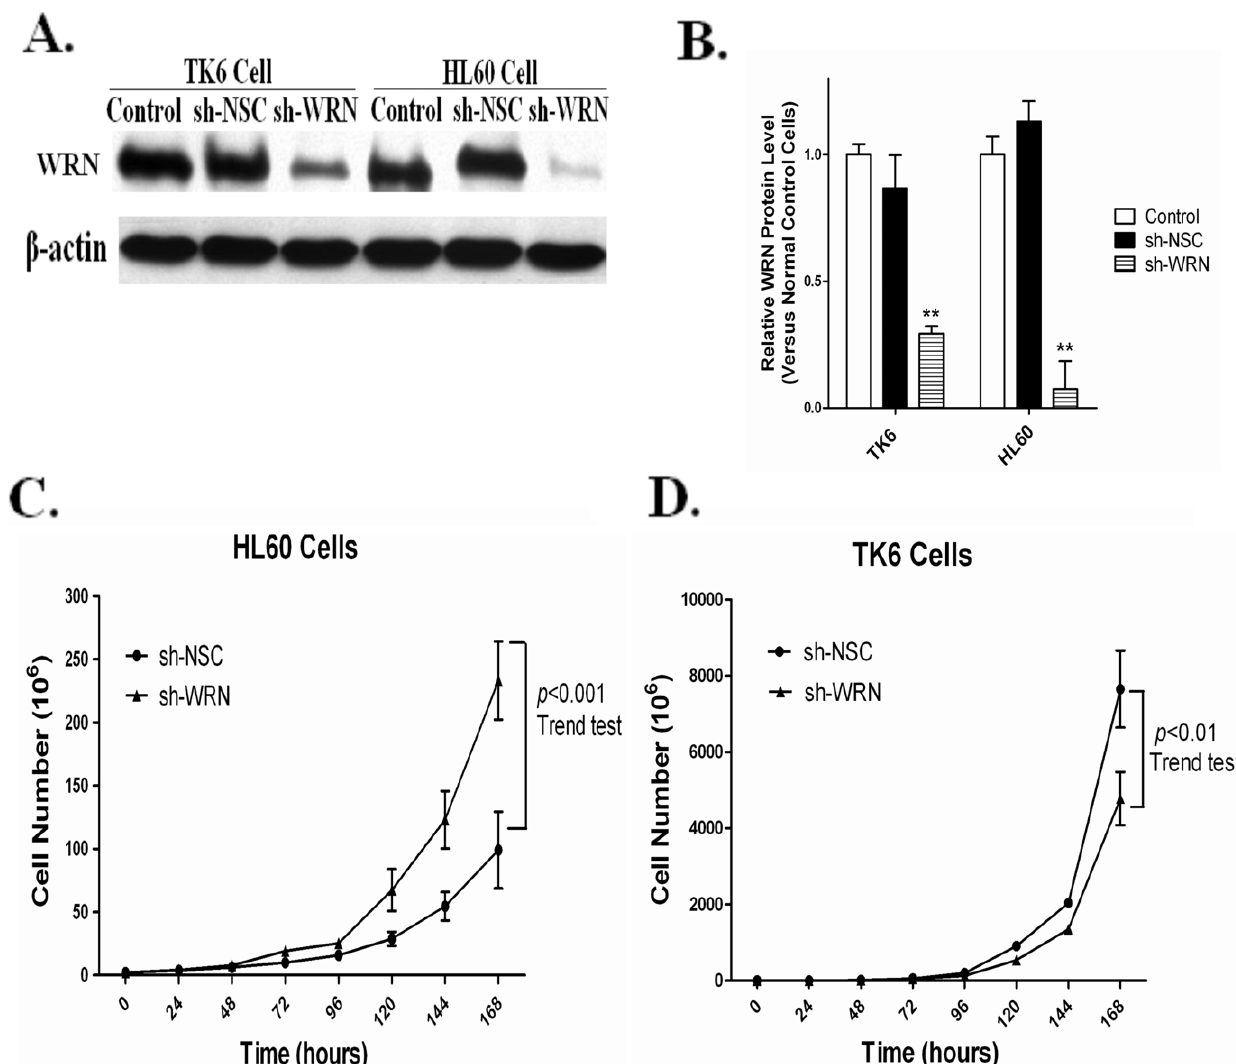
Figure 1. Knockdown of WRN expression in HL60 and TK6 cells leads to altered cell proliferation rates. (A) Immunoblot analysis shows the specific decrease of WRN protein in HL60 and TK6 cells transduced with shRNA constructs targeting WRN . (B) WRN levels were measured and normalized to b -actin. The values presented are mean + SE (n=3) and ** indicates p value , 0.01. (C & D) WRN deficient HL60 and TK6 cells and their relative control cells were cultured over a seven-day period and cell proliferation rates were evaluated using a hemocytometer and the trypan blue exclusion assay. Total cell numbers were plotted against day of initiation. In contrast to HL60 sh-WRN cells that displayed a significantly accelerated proliferation rate (Panel C, Adapted from Ren et al., 2009), the proliferation rate of TK6 sh-WRN cells was slightly decreased (Panel D). The data represents the average of three independent experiments, in which a trend test was performed ( p , 0.01).